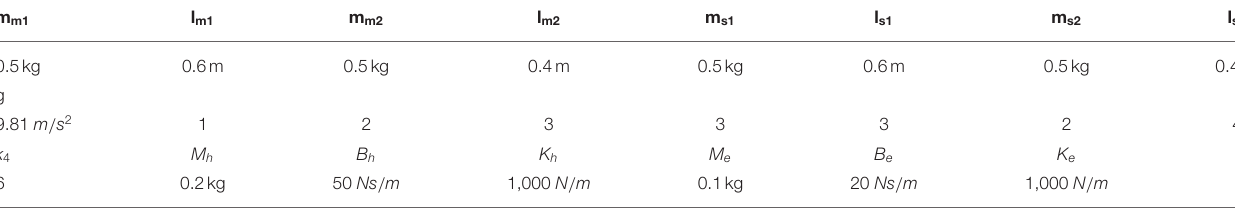
TABLE 1 | Master-slave robot parameters and operator and environment parameters.